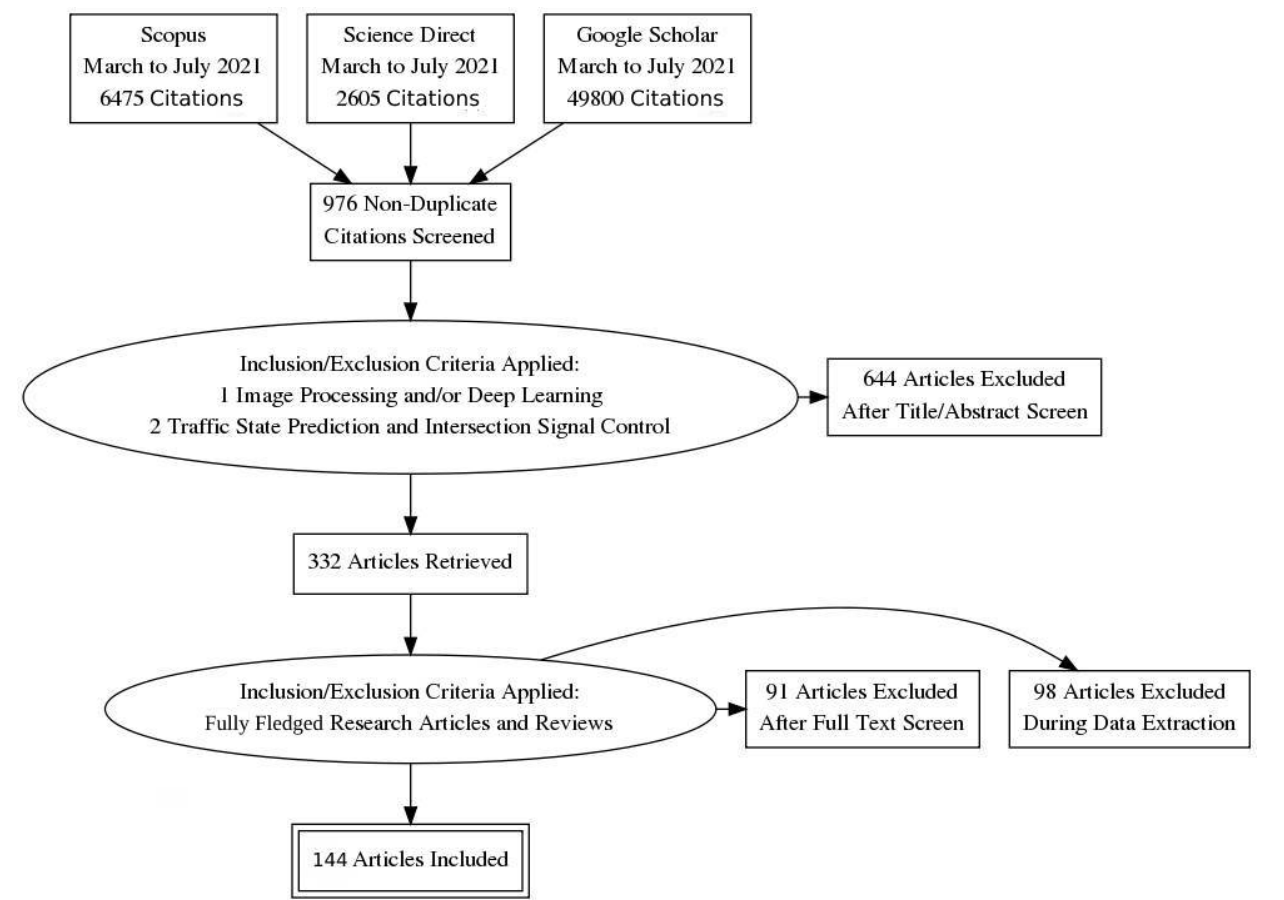
Figure 2. Adopted articles’ selection process on different databases illustrated according to the PRISMA diagram.